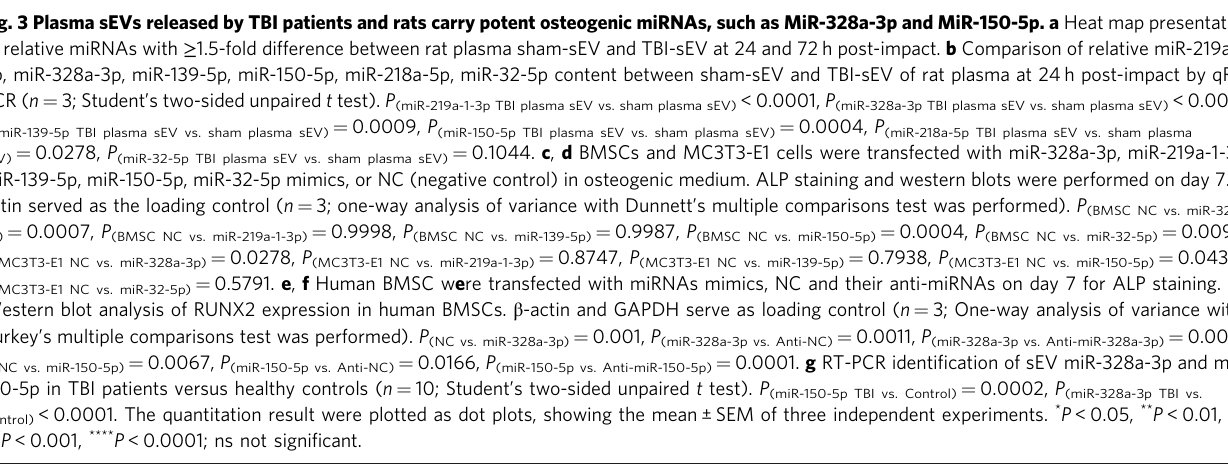
Fig. 3 Plasma sEVs released by TBI patients and rats carry potent osteogenic miRNAs, such as MiR-328a-3p and MiR-150-5p. a Heat map presentation of relative miRNAs with ≥ 1.5-fold difference between rat plasma sham-sEV and TBI-sEV at 24 and 72 h post-impact. b Comparison of relative